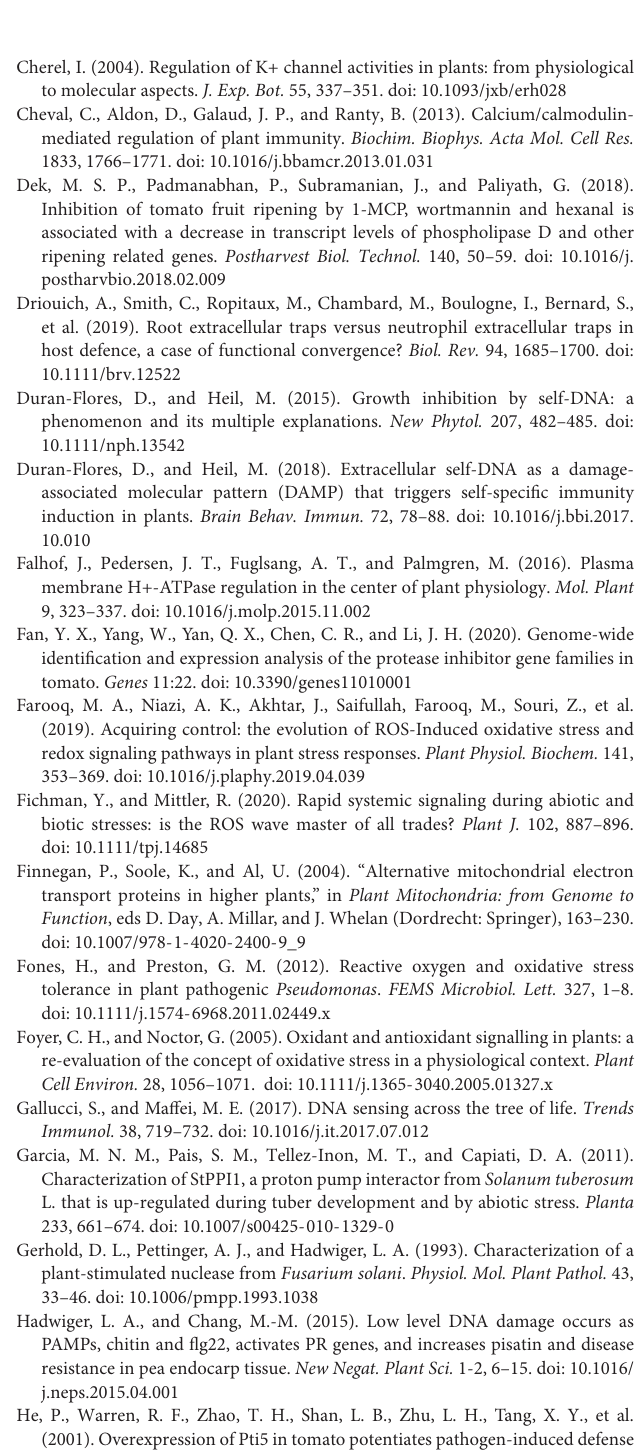
Supplementary Figure 6 | Hierarchical clustering of the expression potential of genes upregulated in response to eDNA against the S. lycopersicum database of Genevestigator. Supplementary Table 1 | Primers used in this work. Supplementary Table 2 | Tomato genes downregulated and upregulated by application of